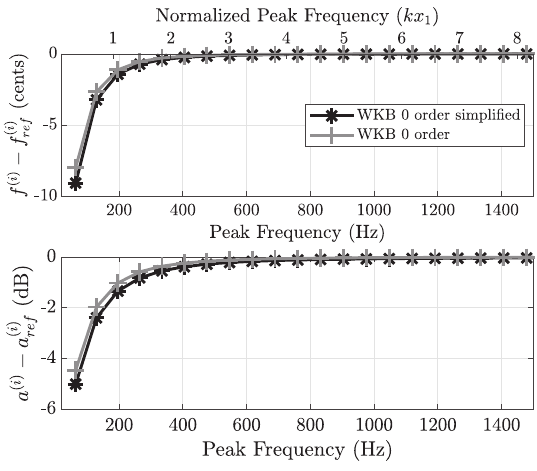
Figure 7. Difference between the resonance parameters of the WKB simulations at the zeroth order (complete and simpli fi ed) to those of the reference impedance: top : frequencies and bottom : magnitudes. In both simulations, the second order approxima- tion is used for the visco-thermal effects.